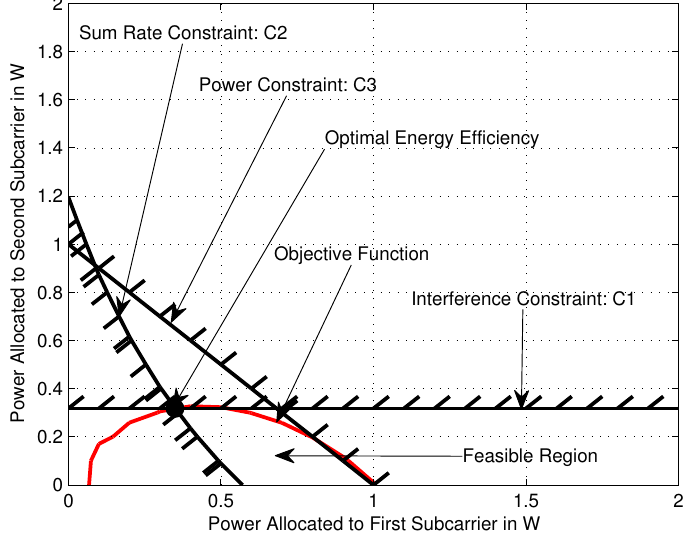
Figure 2. Pictorial view of the optimization objective and all the constraints. The feasible region (common region created by the constraints) and the optimal solution point (solid circle) are also shown. Interference and sum rate constraints are active for this case.